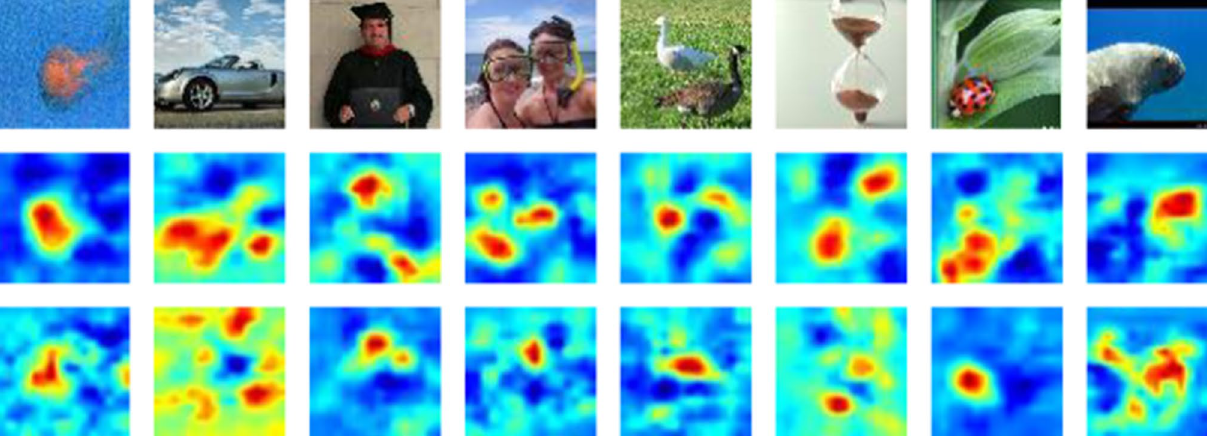
are origins. The second and the last are our class activation mapping and baseline mapping, respectively